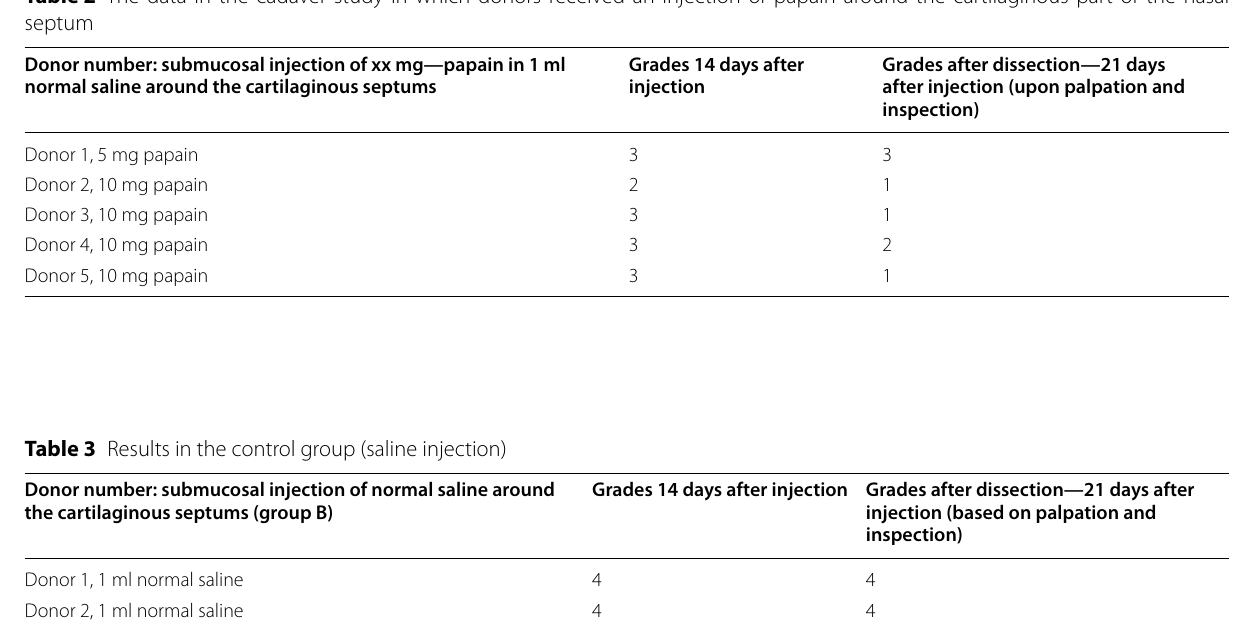
Grades 14 days after injection Grades after dissection—21 days after injection (based on palpation and